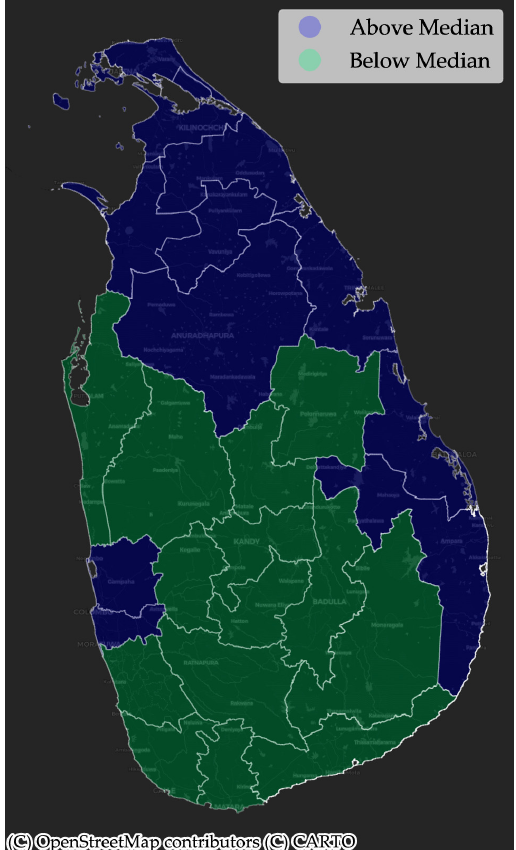
Figure 21. Segregation of Sri Lankan administrative areas using the GTI-IS density